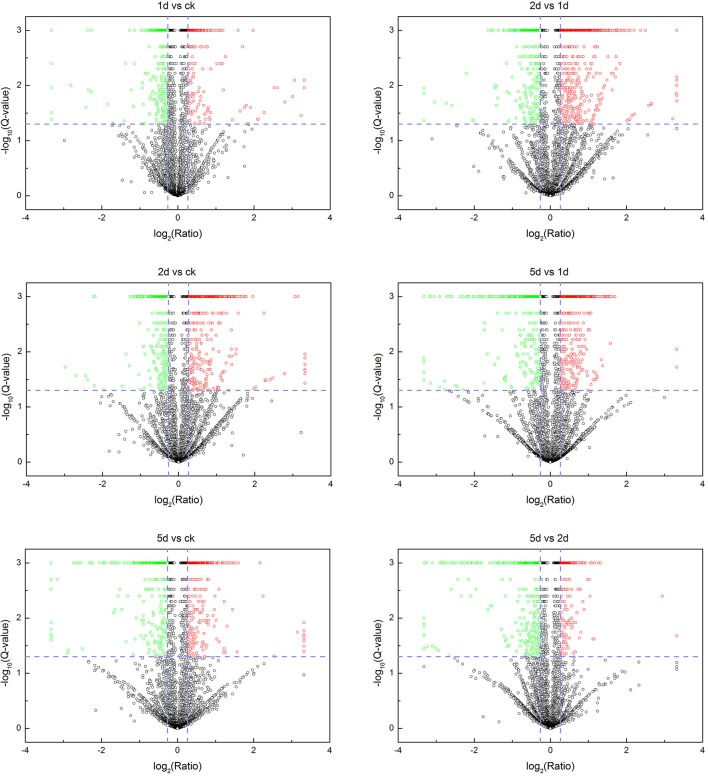
Volcano plots showing fold-change and Q-value for all identified proteins. Each panel shows a certain comparison and each dot represents a protein. Cutoff lines in blue indicate Q < 0.05 and fold change >1.2. Red scatters represent the significantly upregulated proteins, green scatters denote the significantly downregulated proteins, while black scatters indicate the non-significantly expressed proteins.